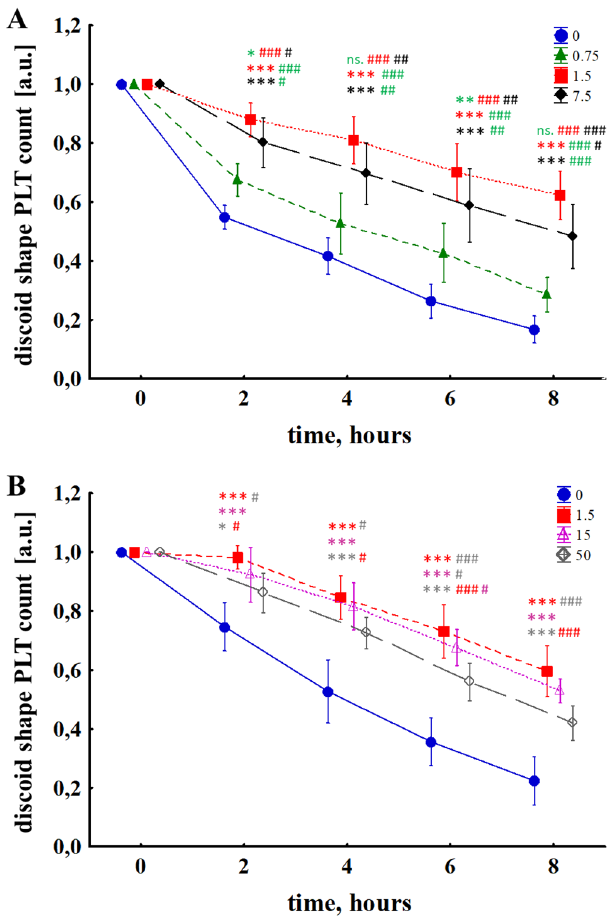
Figure 4. Change in the number of discoid shape PLT subjected to NIR PBM with irradiances: ( A ) 0, 0.75, 1.5, 7.5 mW/cm 2 ; ( B ) 0, 1.5, 15, 50 mW/cm 2 . The MANOVA results for interaction, time, and group were p < 0.001 in each case. The results are presented as mean values ± standard deviation. The number of measurements n = 5 for each group of measurements. The asterisk (*) indicates the differences with regard to the CTR group and the hash (#) indicates the differences between the individual NIR doses at particular time points. *p < 0.05, **p < 0.01, ***p < 0.001; # p < 0.05, ## p < 0.01, ### p < 0.001.